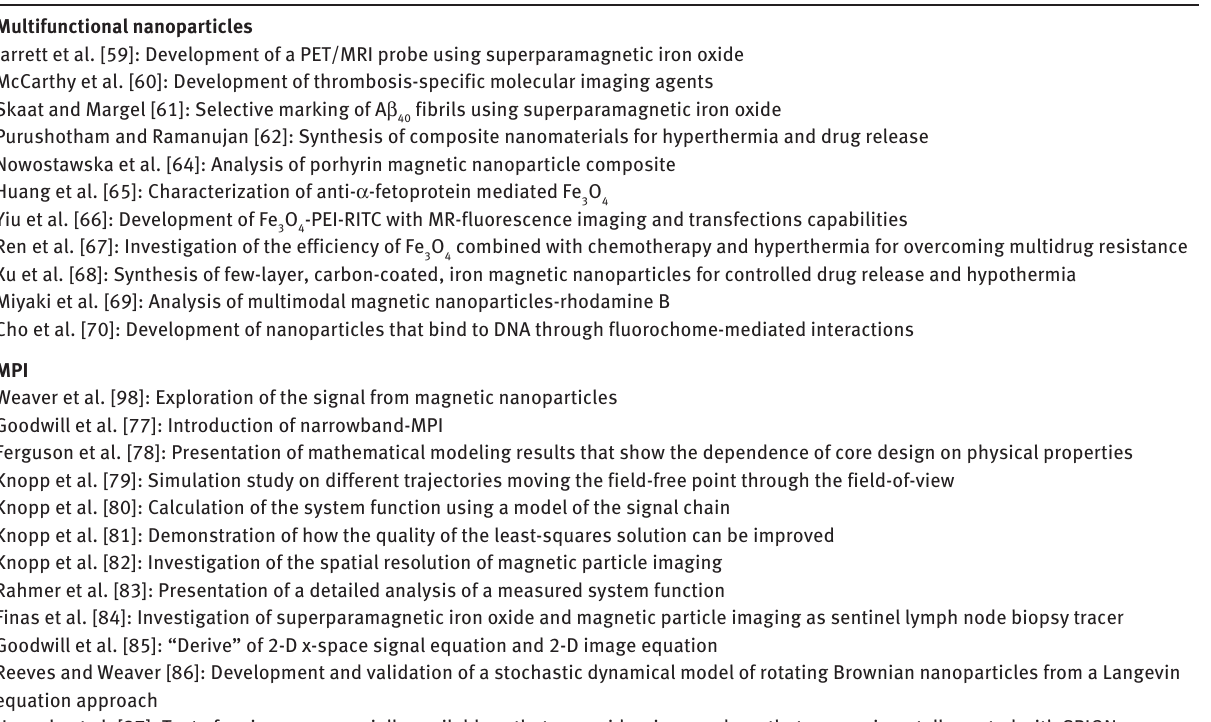
Table 1 Summary of articles showing the development of the past years regarding multimodal nanoparticles, MPI, and magnetorelaxometry